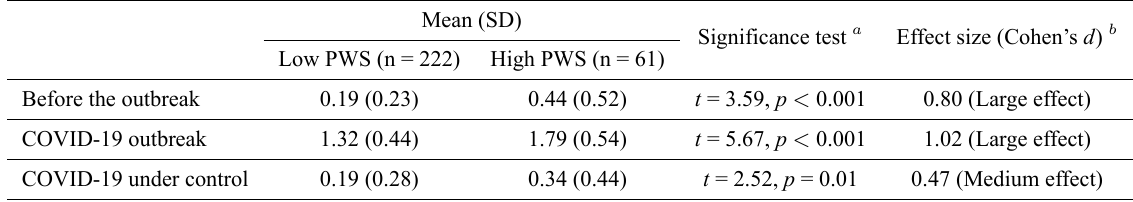
Table 4. DASS-21 scores for high and low PWS